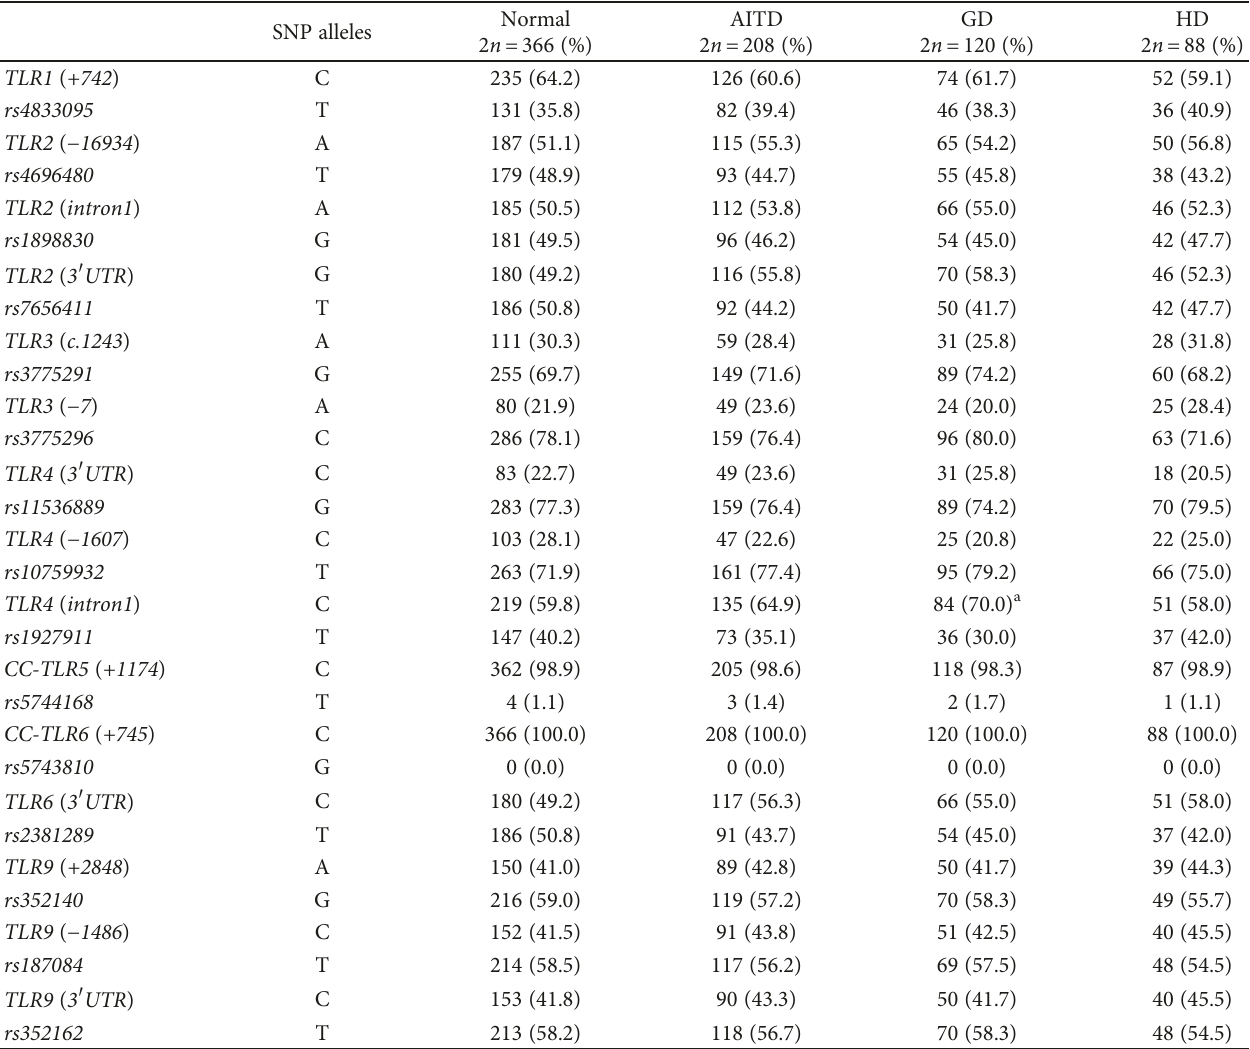
Table 3: Allele frequencies of Toll-like receptor polymorphism in controls and patients with thyroid disease. Normal SNP alleles